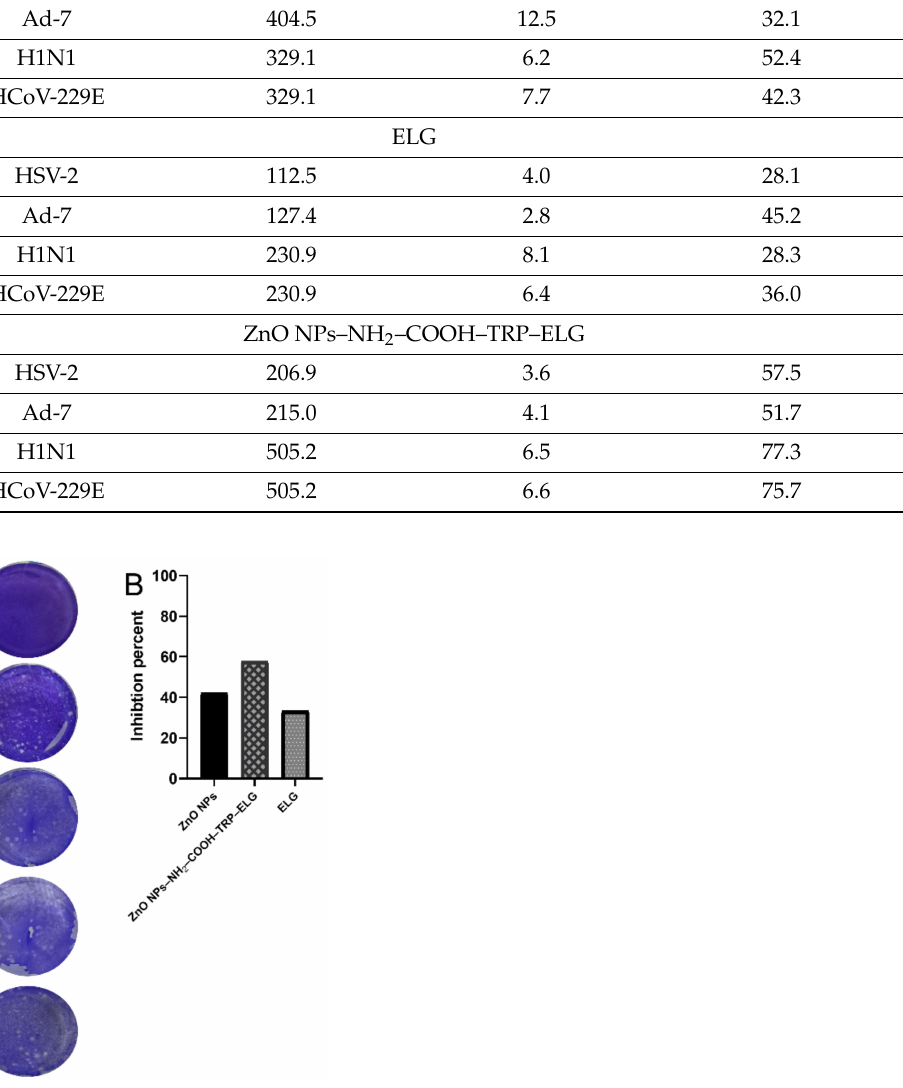
Figure 10. The virucidal mechanism and percent inhibition against coronavirus (HCoV-229E). ( A ) The cytotoxicity control (a), virus control (b), nanoformulation (c), ZnO NPs (d), and ELG (e). ( B ) The percent inhibition of coronavirus (CoV–229E) was calculated from the plaques formed through the virucidal